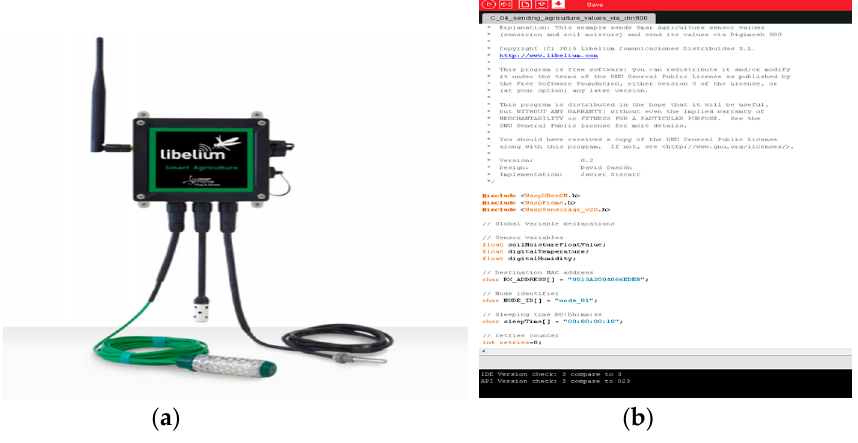
Figure 3. RSSI measurement system: ( a ) commercial Wireless Sensor Network (WSN) node used; ( b ) programming interface.